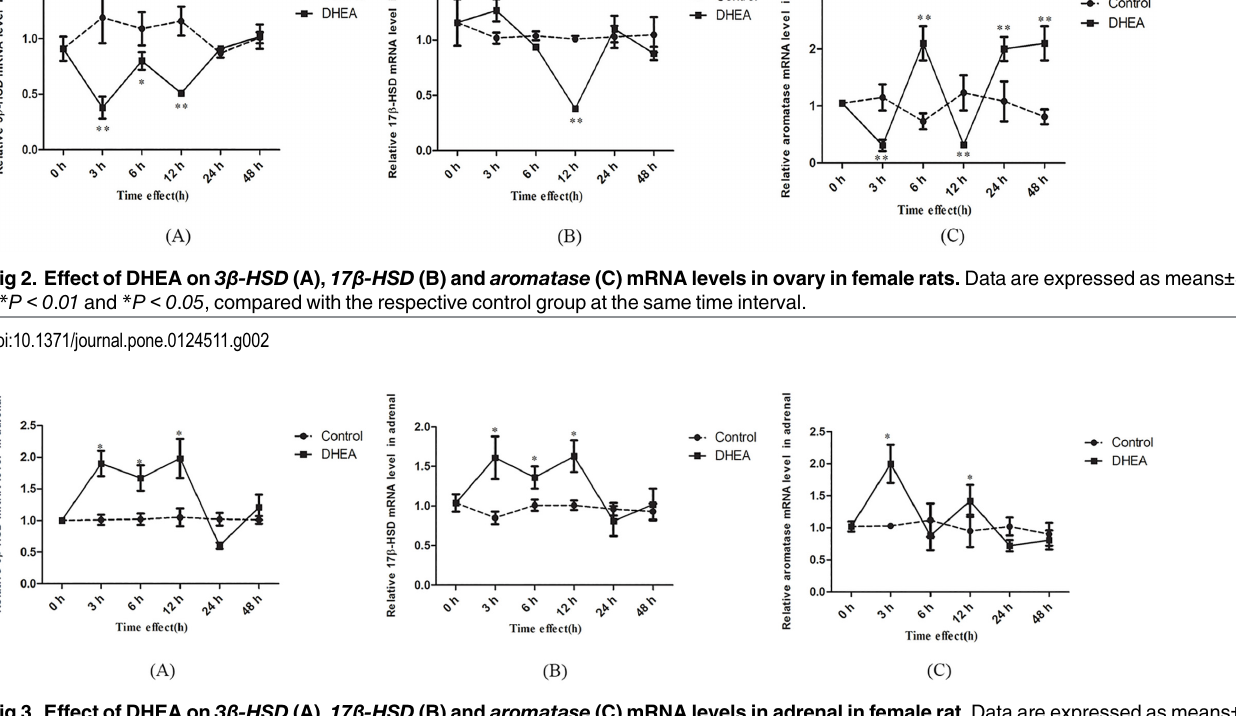
PLOS ONE | DOI:10.1371/journal.pone.0124511 May 11,